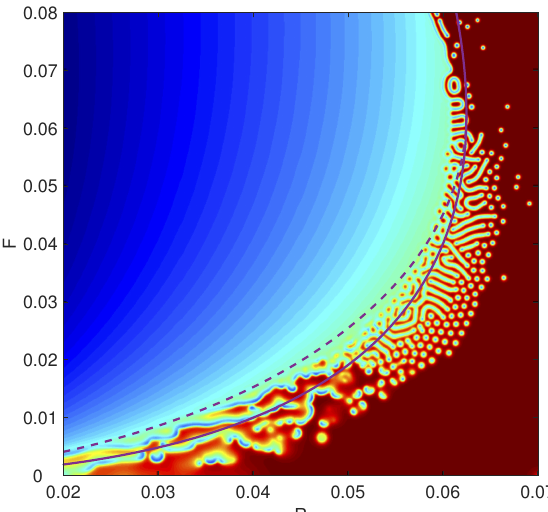
Figure 2. RLBM simulation of a GSRDS, with spatially-varying parameters. The supply rate F and removal rate R are linear functions of the vertical and horizontal coordinate, respectively. The color map shows the order parameter φ ( x , t ) = ψ A ( x , t ) − ψ B ( x , t ) , with red corresponding to values of φ = 1 and the deepest blue corresponding to φ ≈ − 0.5. Also shown is the Hopf bifurcation (dotted line) and the saddle node bifurcation (solid line).